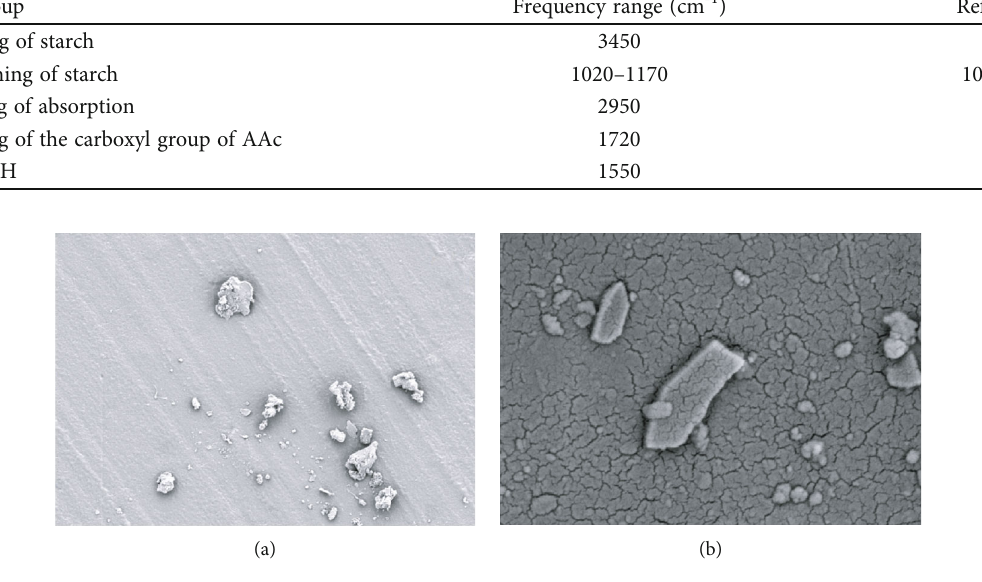
Figure 9: SEM images of SAH: (a) UHG and (b)